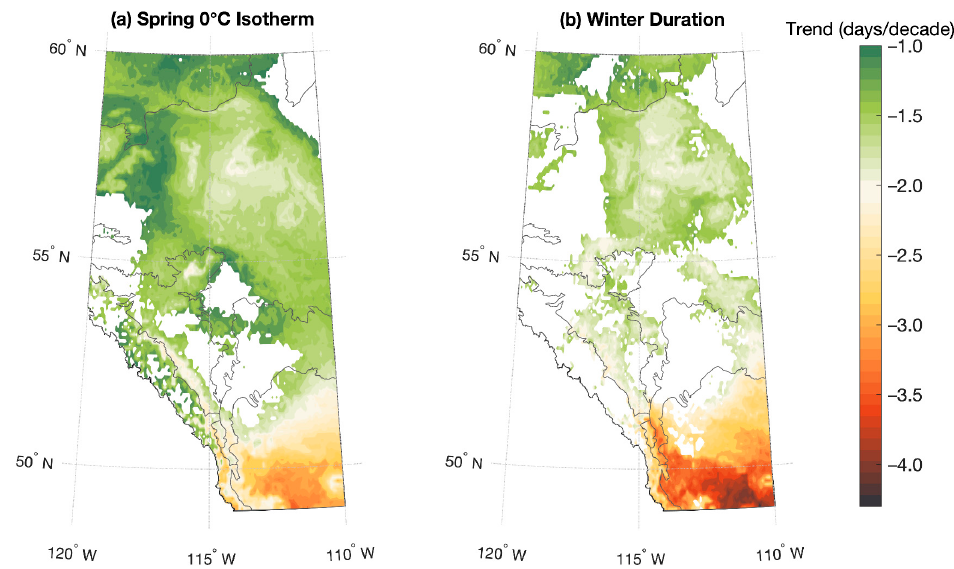
Figure 2. Trends (days/decade) in ( a ) spring 0 °C isotherm dates and ( b ) winter duration over the historic period (1950–2017). Only trends significant at p < 0.05 are shown.